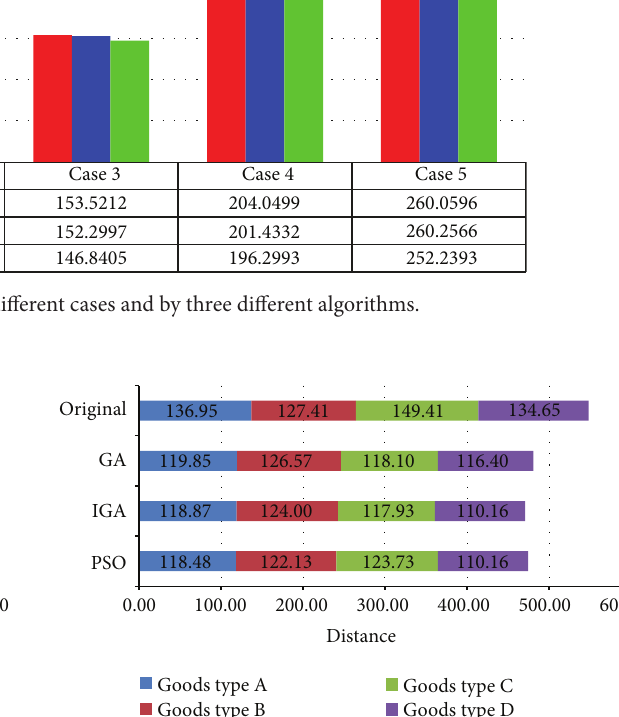
Figure 15: The Gantt chart for different travelled distances under Case 3.